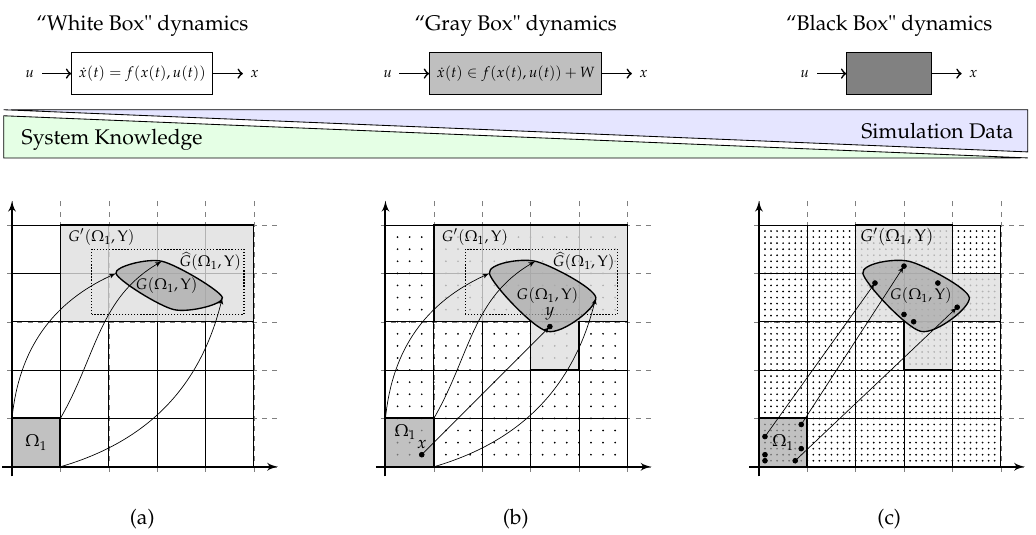
Figure 3. Illustration of the computation of a discrete approximation for a 2-dimensional plant in